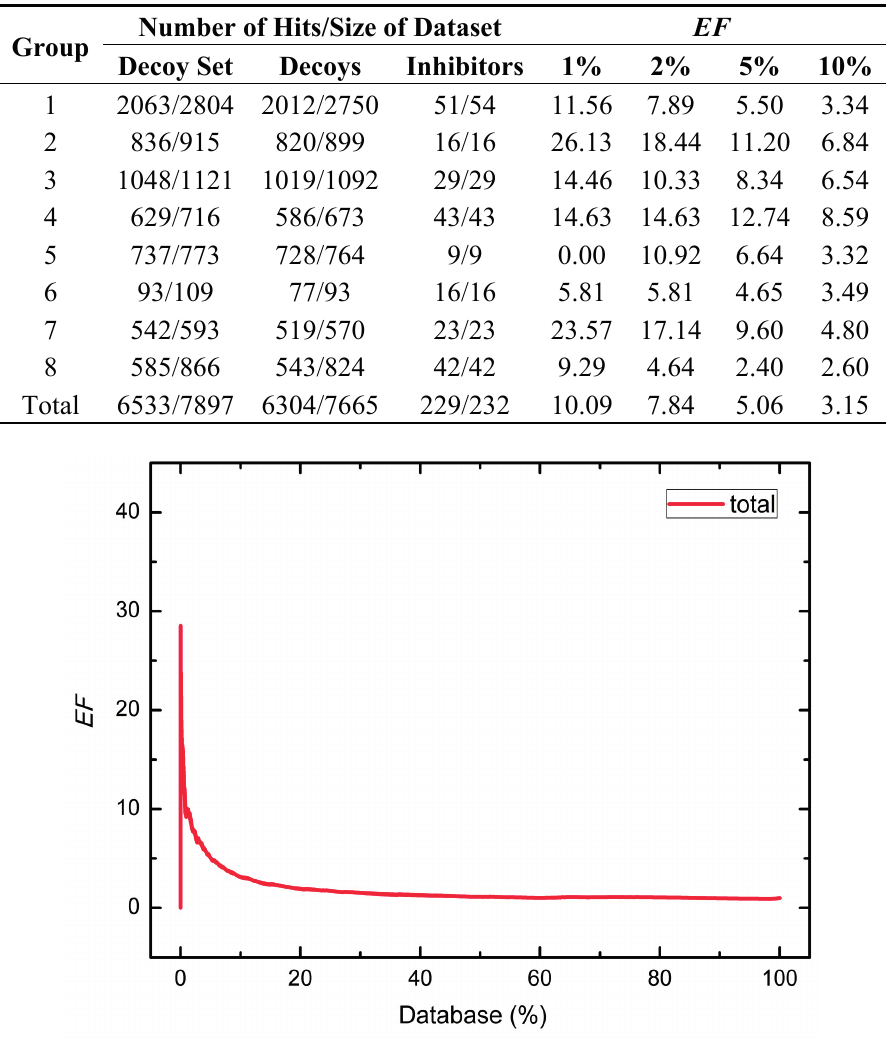
Figure 5. EF curve of the whole decoys